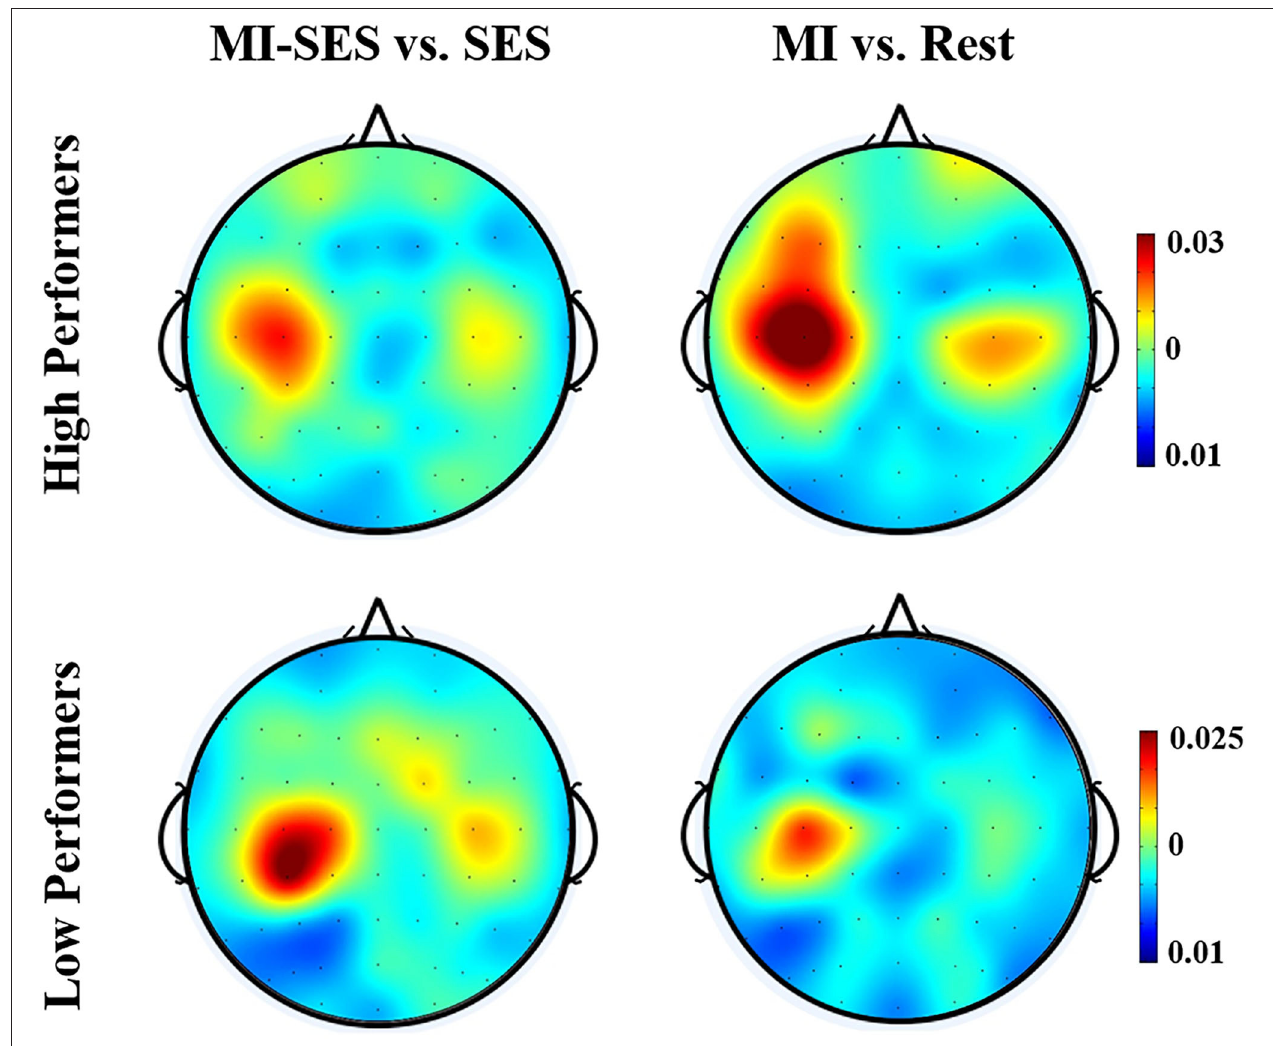
FIGURE 6 | Averaged topographical distributions of r 2 during period [3 5] s for all High Performers and all Low